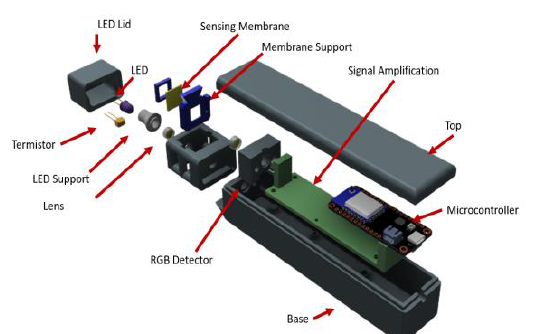
Fig. 1. Exploded view of the sensing prototype showing all the internal components